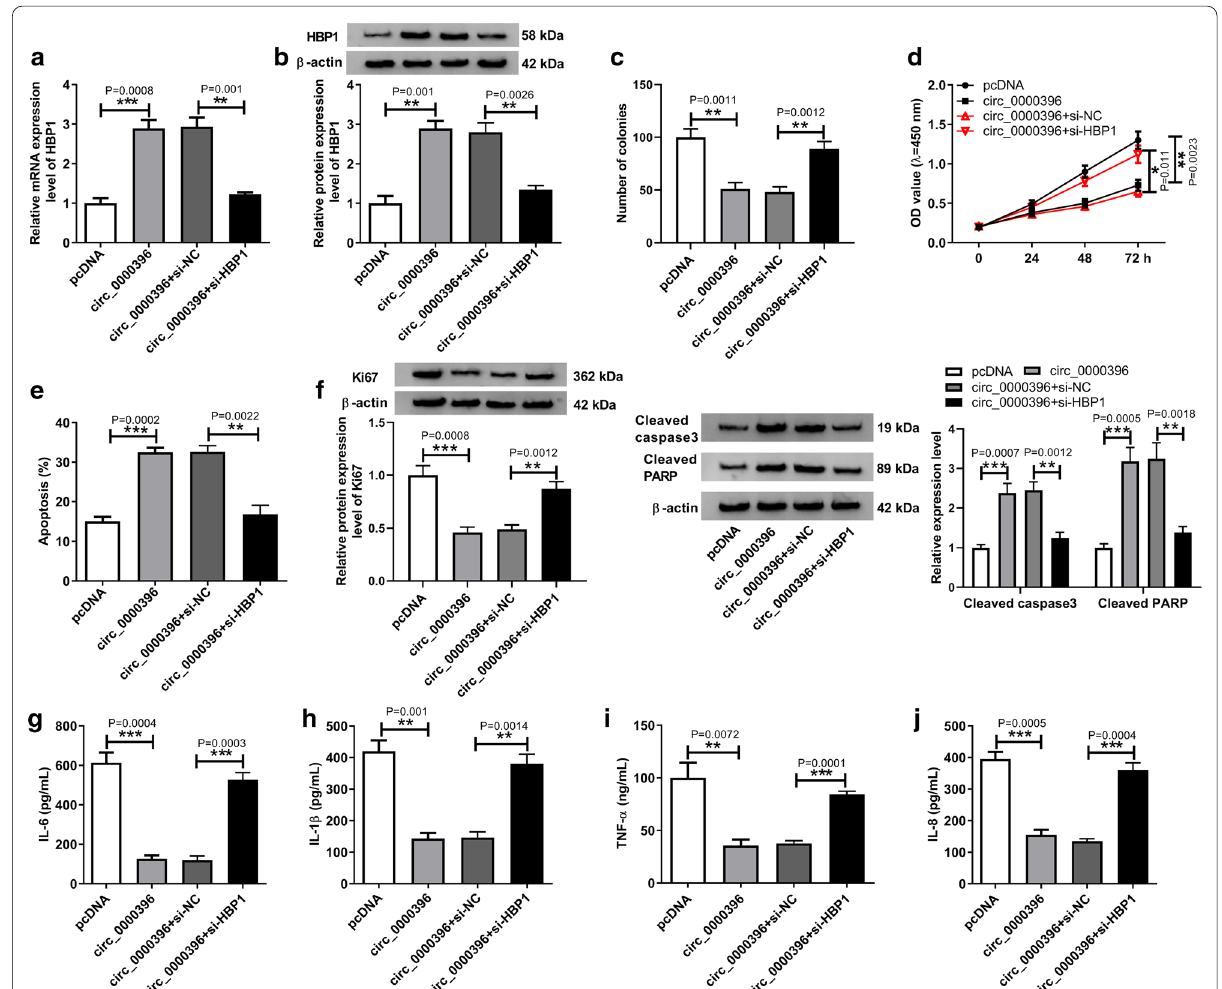
Fig. 7 Circ_0000396 affects the growth and inflammation of RASFs through modulating HBP1. RASFs were transfected with pcDNA, circ_0000396, circ_0000396 si-NC, or circ_0000396 si-HBP1. a , b Transfection efficiency was analyzed by using qRT-PCR or western blot. c , d The proliferation + + of RASFs was determined using colony formation assay and CCK-8 assay. e The apoptosis rate of RASFs was detected using flow cytometry. f The expression of Ki67, cleaved caspase3 and cleaved PARP expression in RASFs was detected using western blot. g – j Levels of inflammatory cytokines IL-6, IL-1β, IL-8 and TNF-α in RASFs was detected by ELISA assay. * p < 0.05, ** p < 0.01, *** p < 0.001, **** p < 0.0001